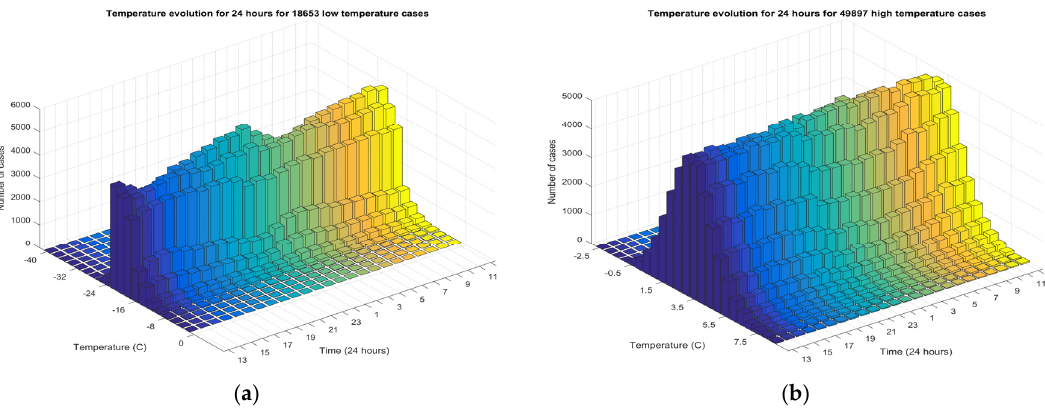
Figure 2. ( a ) Temperature evolution for 18,653 LT cases during a 24 h period from 12:30 p.m. to 12:30 p.m. of the next day with CPT below − 1 °C; ( b ) Temperature evolution for 49,897 HT cases for the same period of time with CPT above − 1 °C.